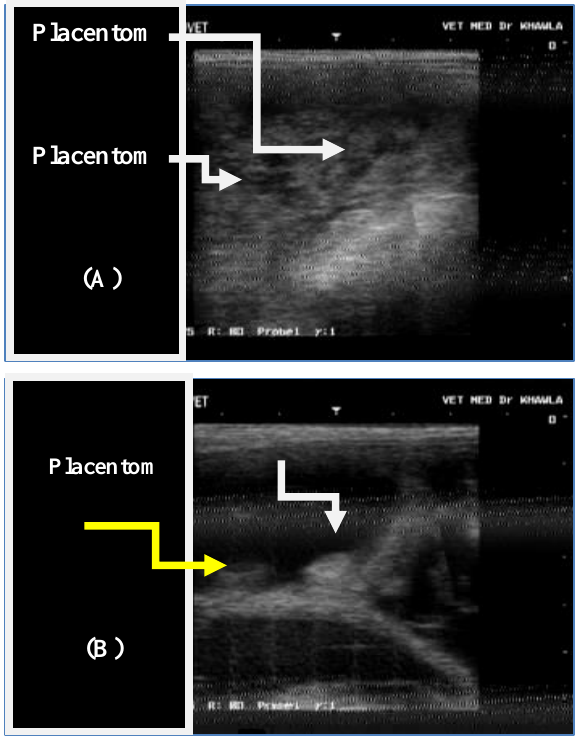
Figure, 1: Placentom size (mm) at day 35 of pregnancy in Shami goats in Iraq early stage. (A) in single pregnancy (B) in twin